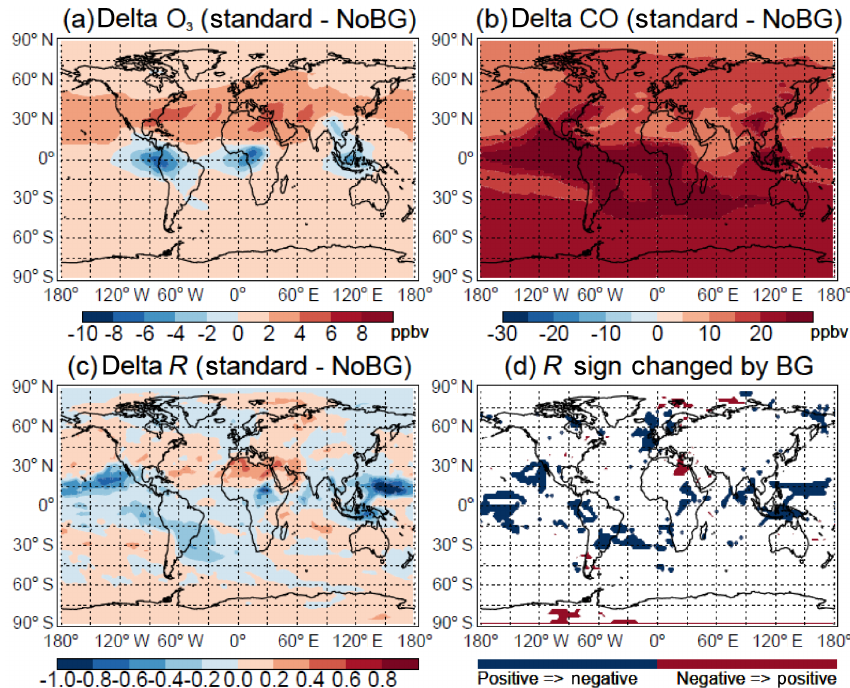
Figure 18. Same as Fig. 16 but for the sensitivity of O 3 , CO, and their correlations at 618hPa to biogenic (BG)